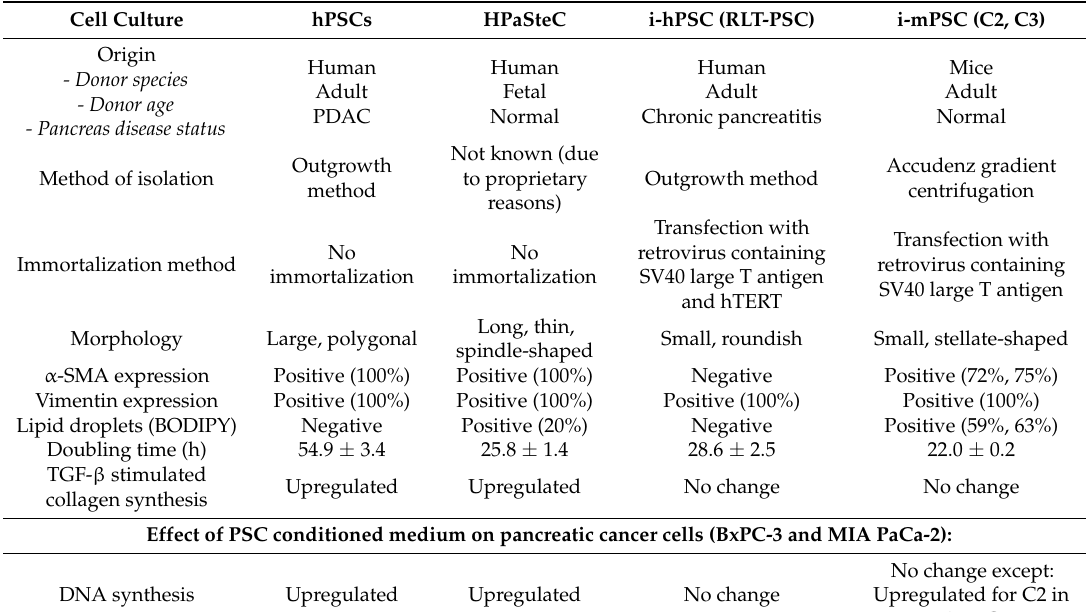
Table 1. Characteristics of the various pancreatic stellate cell (PSC)